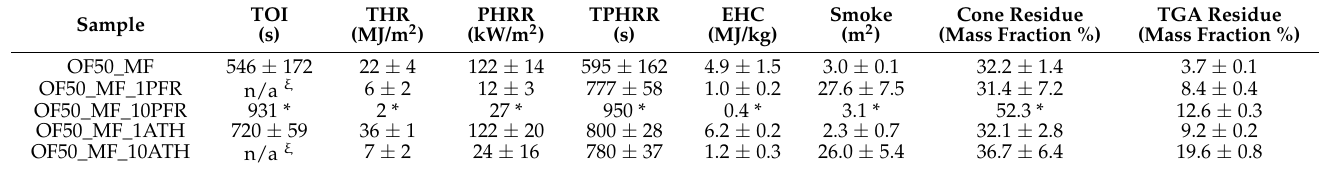
Figure 5. Representative heat release rate (HRR) curves measured by cone calorimetry. Table 4. Cone calorimetry data and Thermo-Gravimetric Analysis (TGA)